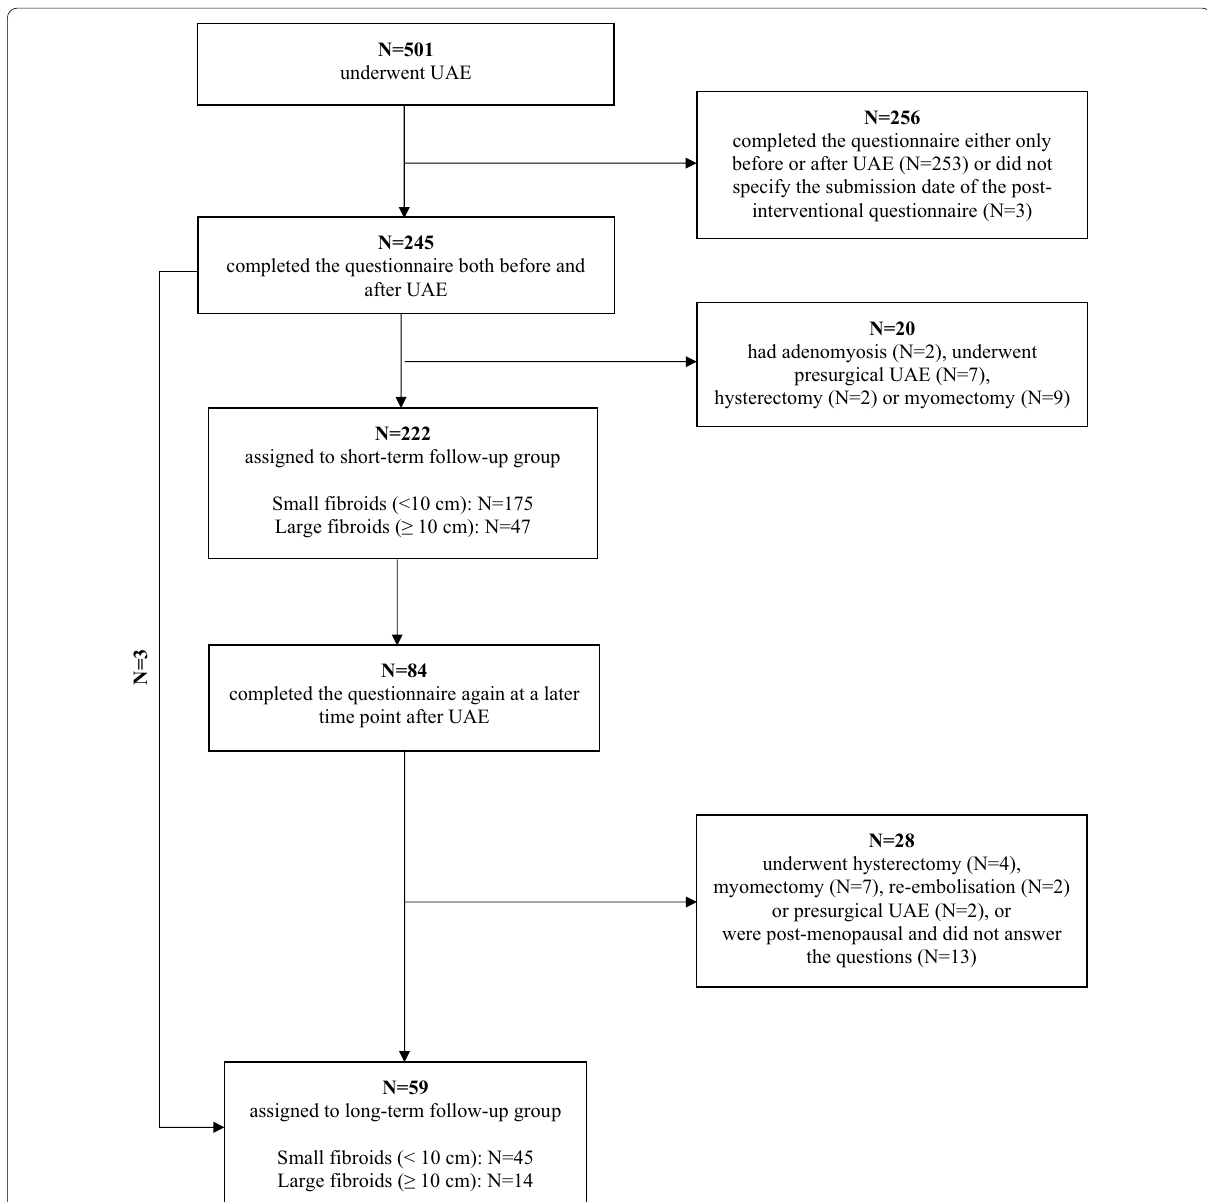
Fig. 3 Flow diagram of patients included and excluded over the course of the